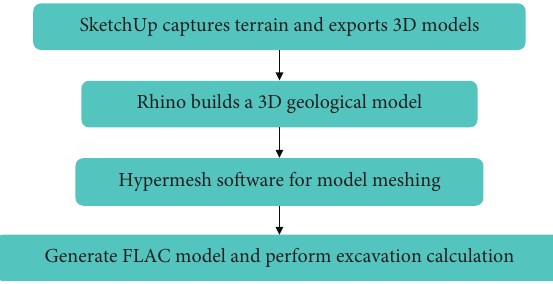
Figure 3: The modeling process.